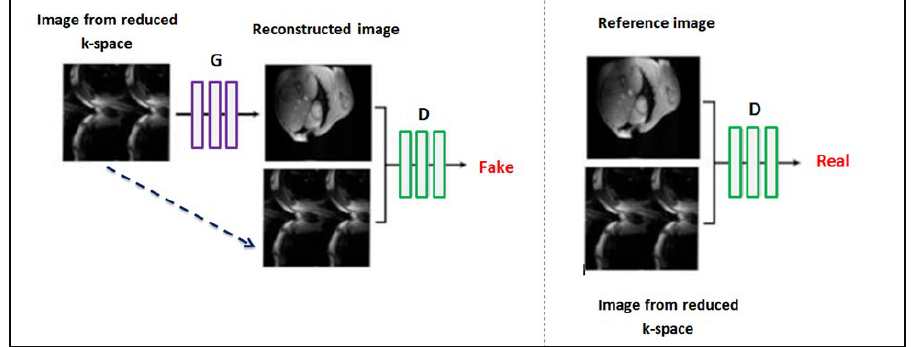
Figure 4. The CGAN model architecture. The generator employs the U-Net architecture, whereas the discriminator is a convolutional network.